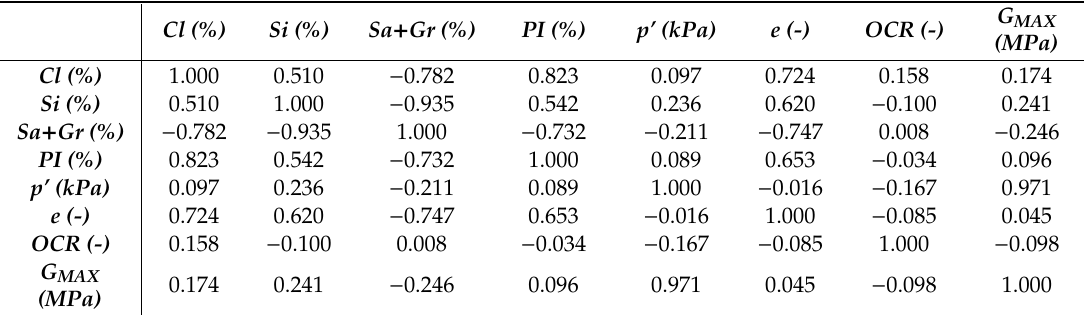
Table 5. Correlation matrix for tested soils where Cl, Si and Sa + Gr is the clay, silt and sand and gravel